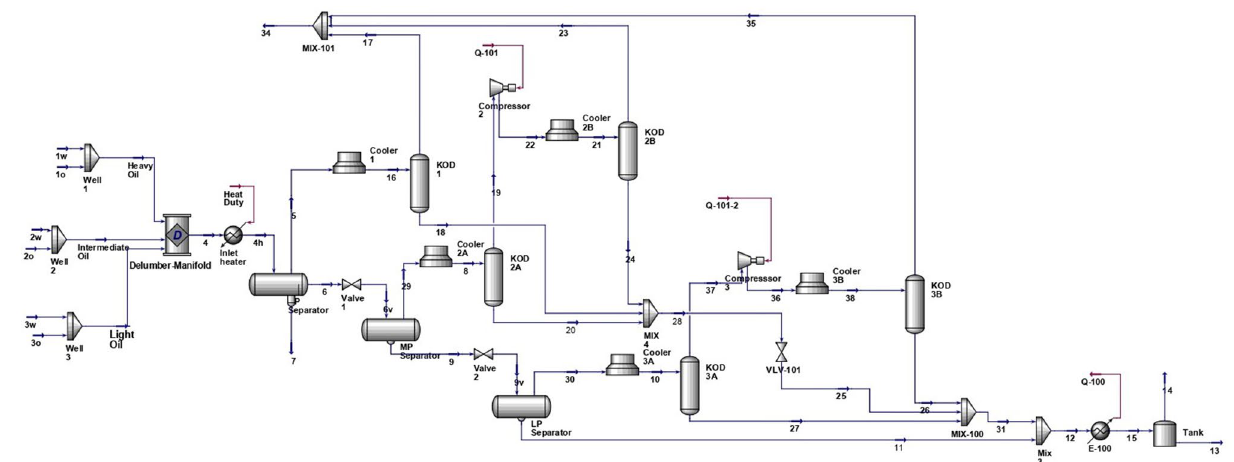
Fig. 3 Process configuration of the oil processing unit combined with vapour recovery unit